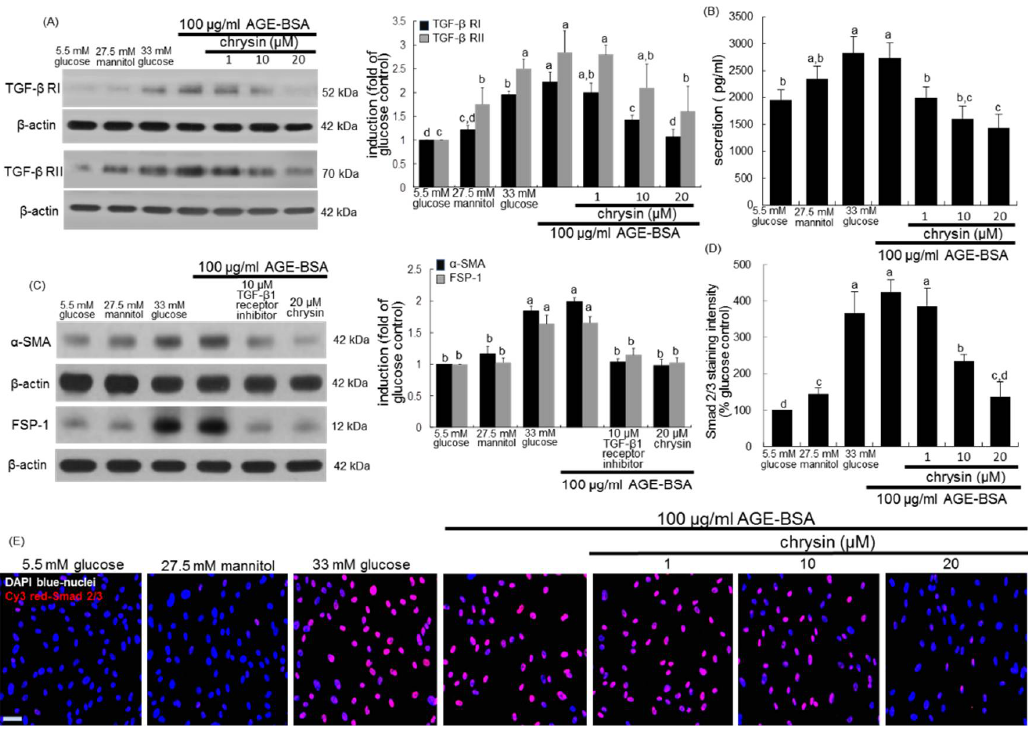
Figure 7. Blockade of TGF-β1 secretion, its receptor (RI and RII) induction and Smad 2/3 activation by chrysin in renal mesangial cells treated with AGE. Human renal mesangial cells were challenged for 3 days with 100 μg/mL AGE-BSA in the absence and presence of 1–20 μM chrysin or 10 μM TGF-β RI kinase inhibitor. Cell extracts and media were subject to Western blot analysis with a primary antibody against TGF-β RI, TGF-β RII, α-SMA and FSP-1 ( A , C ). β-Actin protein was used as an internal control. The bar graphs in the right panels represent densitometric results obtained from Image analysis. TGF-β1 in culture media was measured by using an ELISA kit ( B ). Cy3 staining was conducted for the nuclear Smad 2/3 detection with nuclear counter-staining of DAPI ( D , E ). Each photograph is representative of at least 4 different experiments and fluorescent images were taken with a fluorescence microscope. Scale bar = 100 μm. Fluorescent Cy3 staining intensity of Smad 2/3 was measured using an optical Axiomager microscope system ( D ). Values in bar graphs (mean ± SEM, n = 3 independent experiments) not sharing a same lower case indicate significant different at p < 0.05.